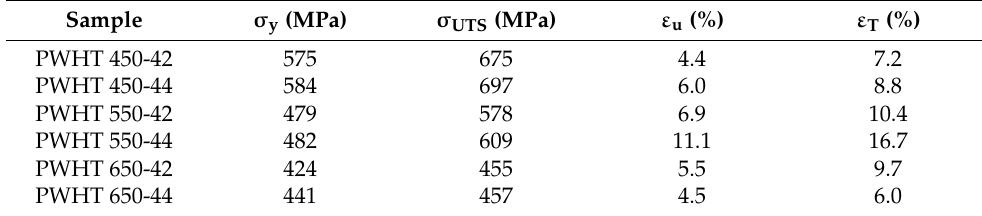
Table 4. Resultant tensile properties of FSWed DP780 with different annealing